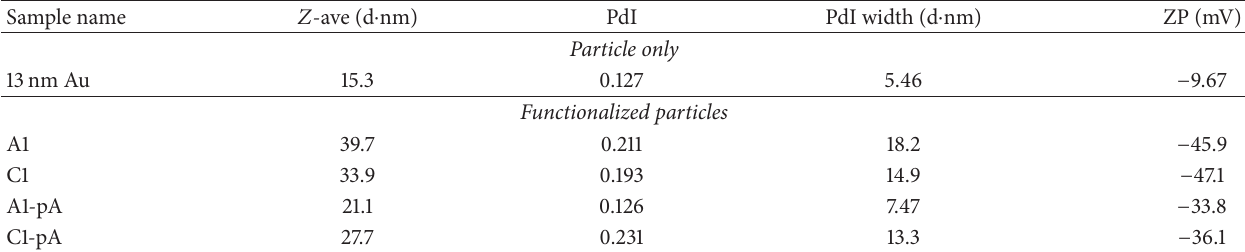
Table 1: Dynamic Light Scattering (DLS) and Laser Doppler Velocimetry (LDV) results for unfunctionalized and ssDNA functionalized 13nm Au